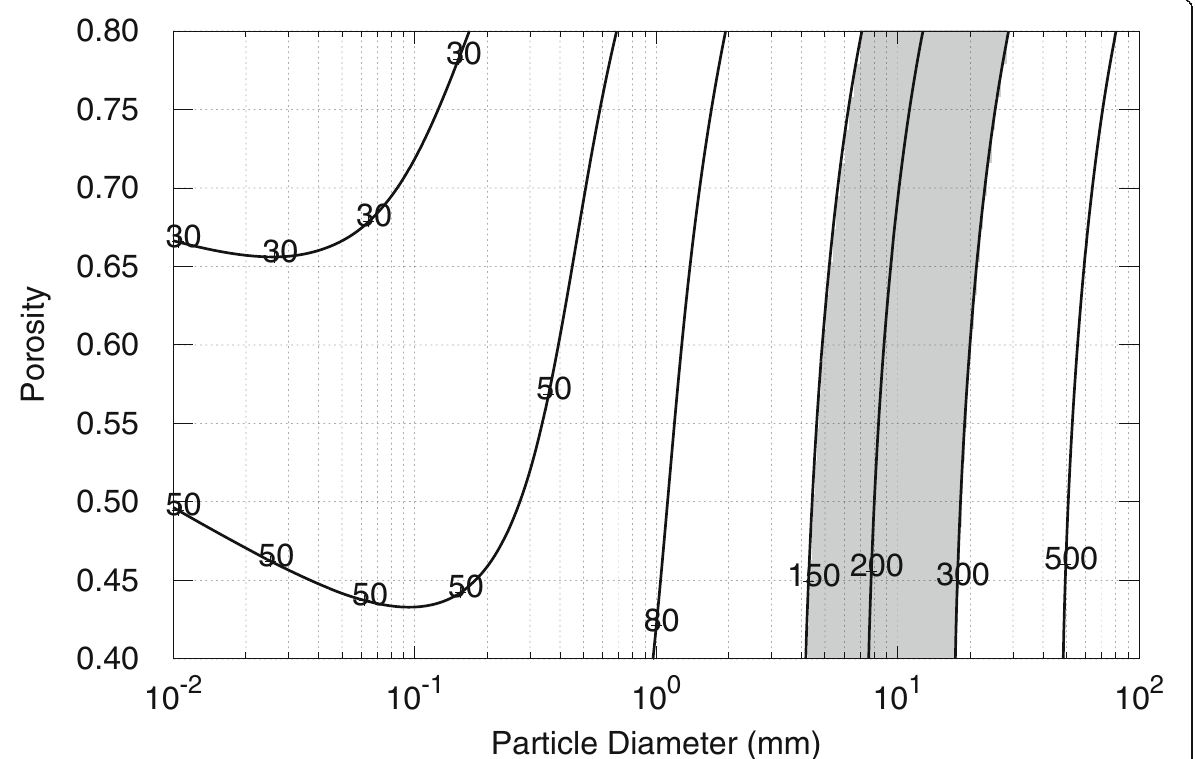
Fig. 6 Contour plot of thermal inertia (in units of J m − 2 s − 1/2 K − 1 ) as a function of particle diameter and porosity. The gray-filled region indicates the thermal inertia range estimated for Ryugu by ground-based observations (Müller et al. 2017). The regolith parameters assumed in the calculation are c p = 758 J kg − 1 K − 1 , T = 300 K, ρ m = 3110 kg m − 3 , k m = 0.0021 T + 1.19 W m − 1 K − 1 , γ = 0.032 J m − 2 , ν = 0.25, E = 78 GPa, ϵ = 1.0, ξ = 0.12, z = 0.01 m, and g = 1.8× 10 – 4 m s − 2 , respectively. γ and ξ were optimized for experimental data of lunar regolith simulant JSC-1A (Sakatani et al.